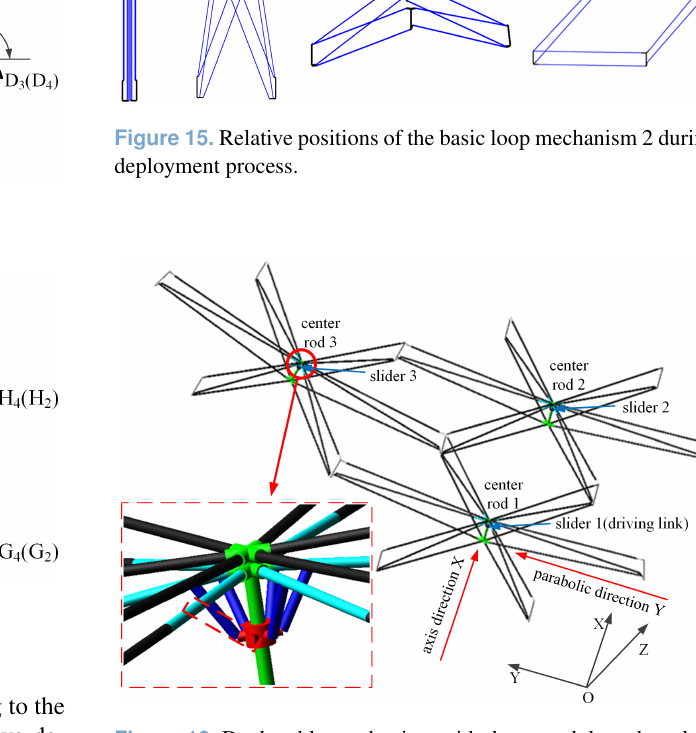
Figure 16. Deployable mechanism with three modules – based on the first design scheme.